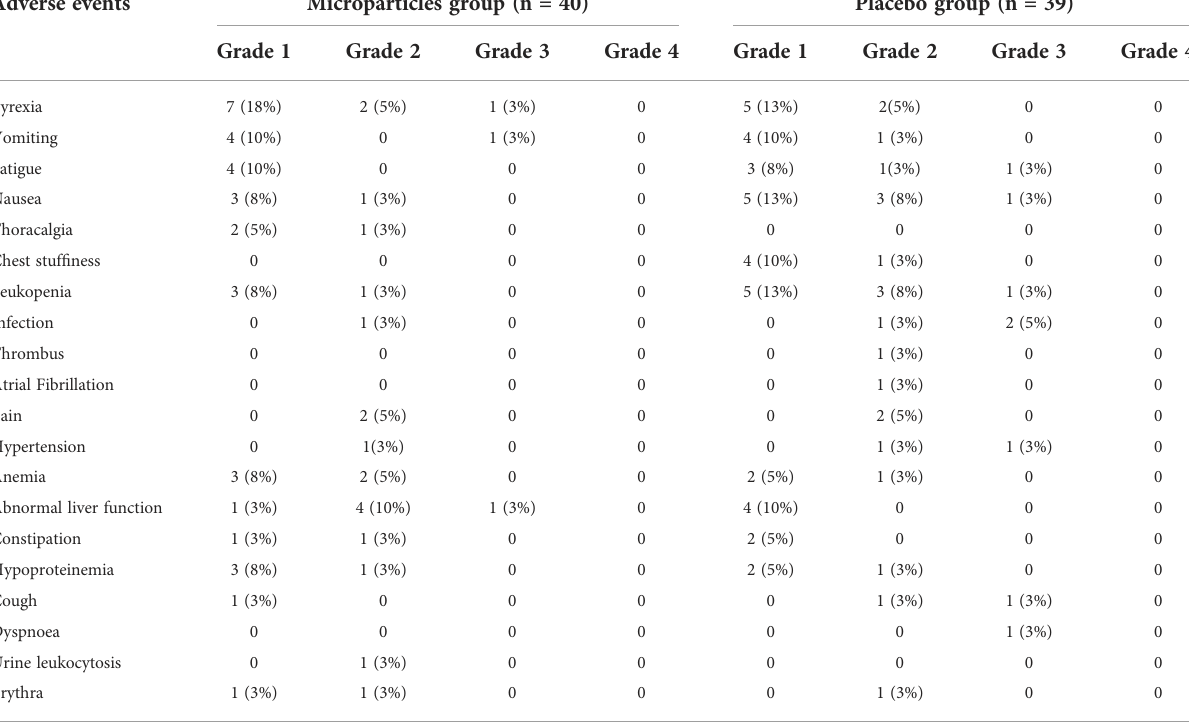
TABLE 3 Adverse